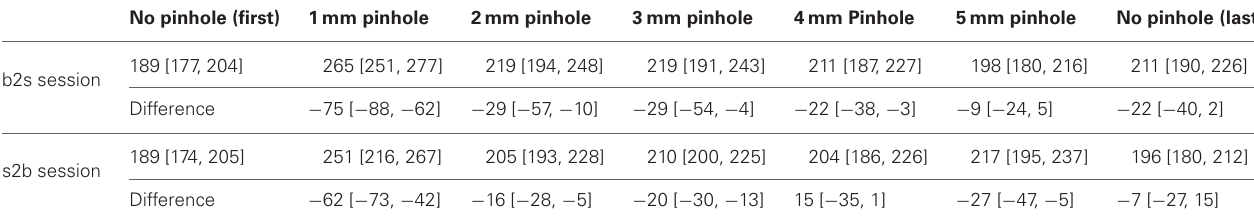
FIGURE 13 | Boxplots of 50% integration times. Boxplots 1–7 show 50ITs across all pinhole subjects, in each pinhole condition. Boxplots 8–11 show old subjects’ 50ITs from the two brightest conditions of the luminance Table 3 | 50% integration times (50IT) for all pinhole